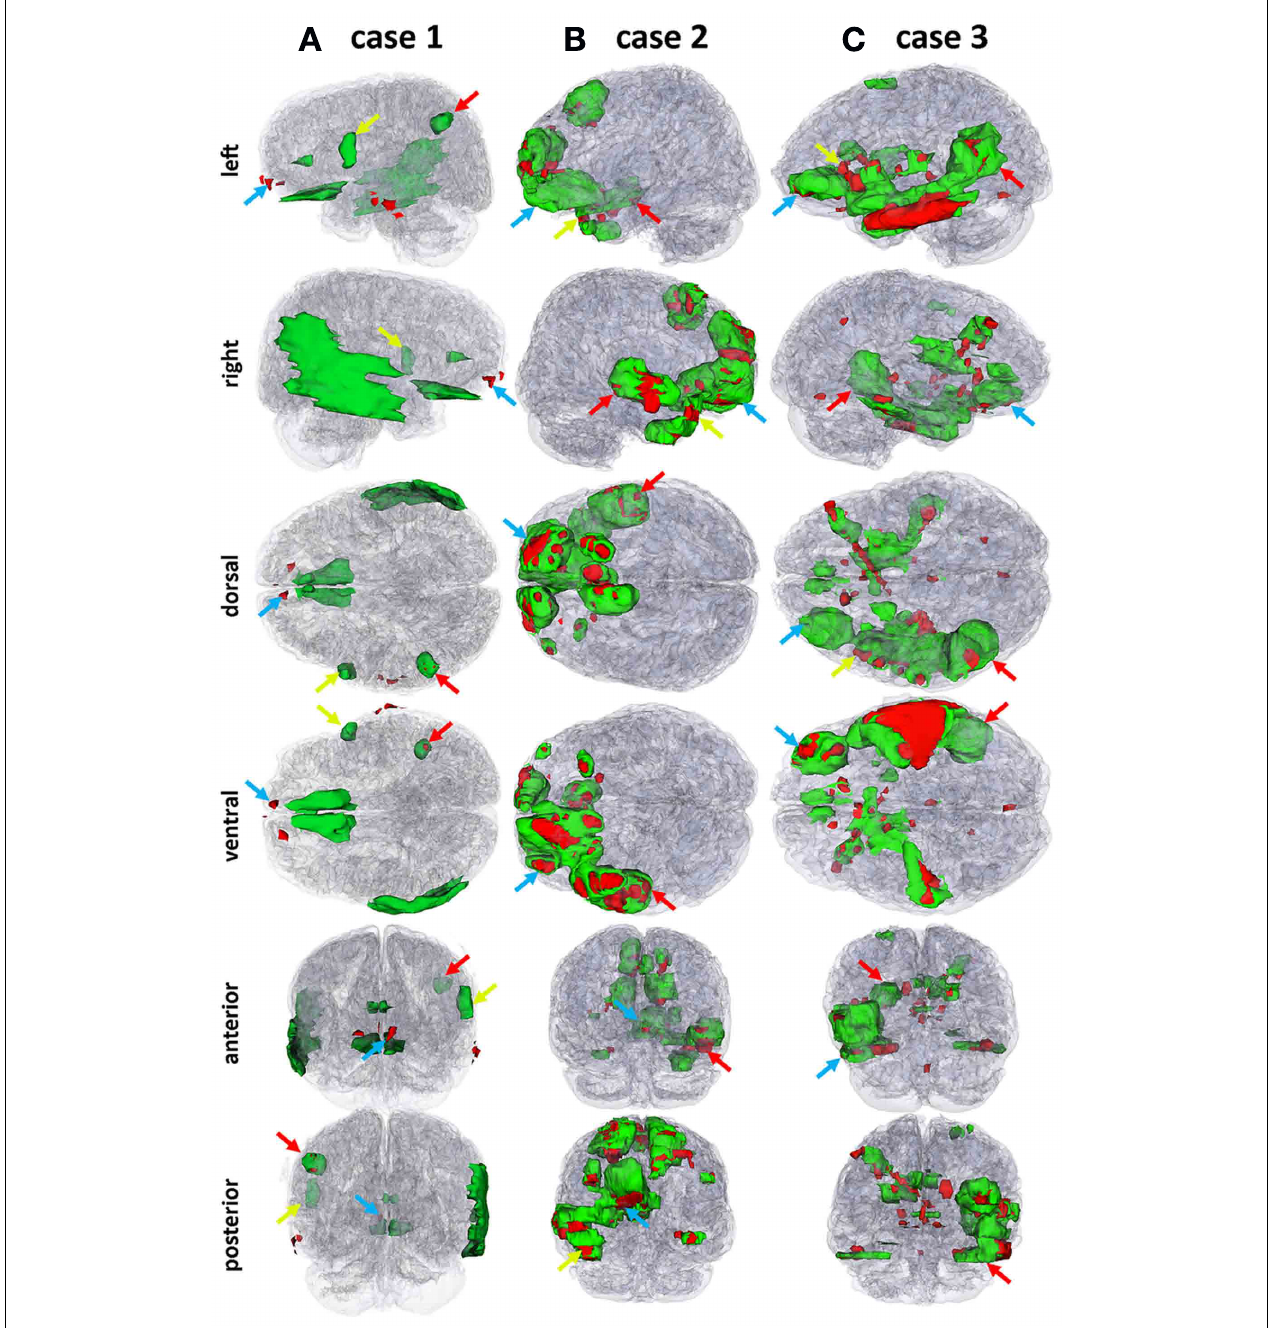
color-coded (red, green, and blue) arrows are provided to identify the locations of the insults indicated in Figure 1 using corresponding colors. Each column ( A , B , and C ) corresponds to one of the three cases (1, 2 or 3,